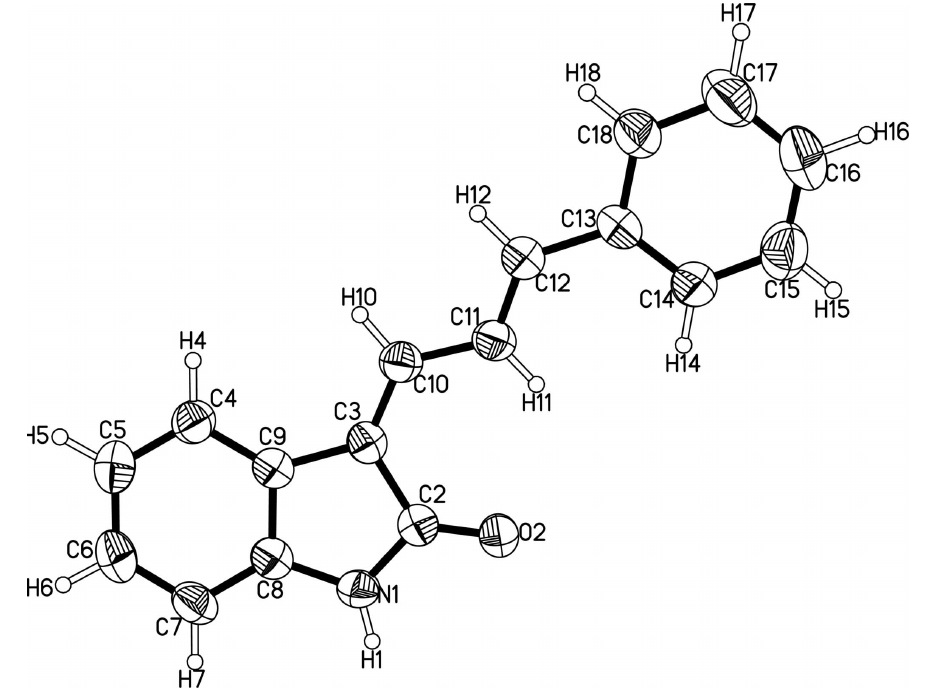
Figure 1 A view of one of the independent molecules with displacement ellipsoids drawn at the 40% probability level. H atoms are presented as open circles with arbitrary radii. Atoms of another independent molecule were labeled as N21 H21 C22 O22 through C38